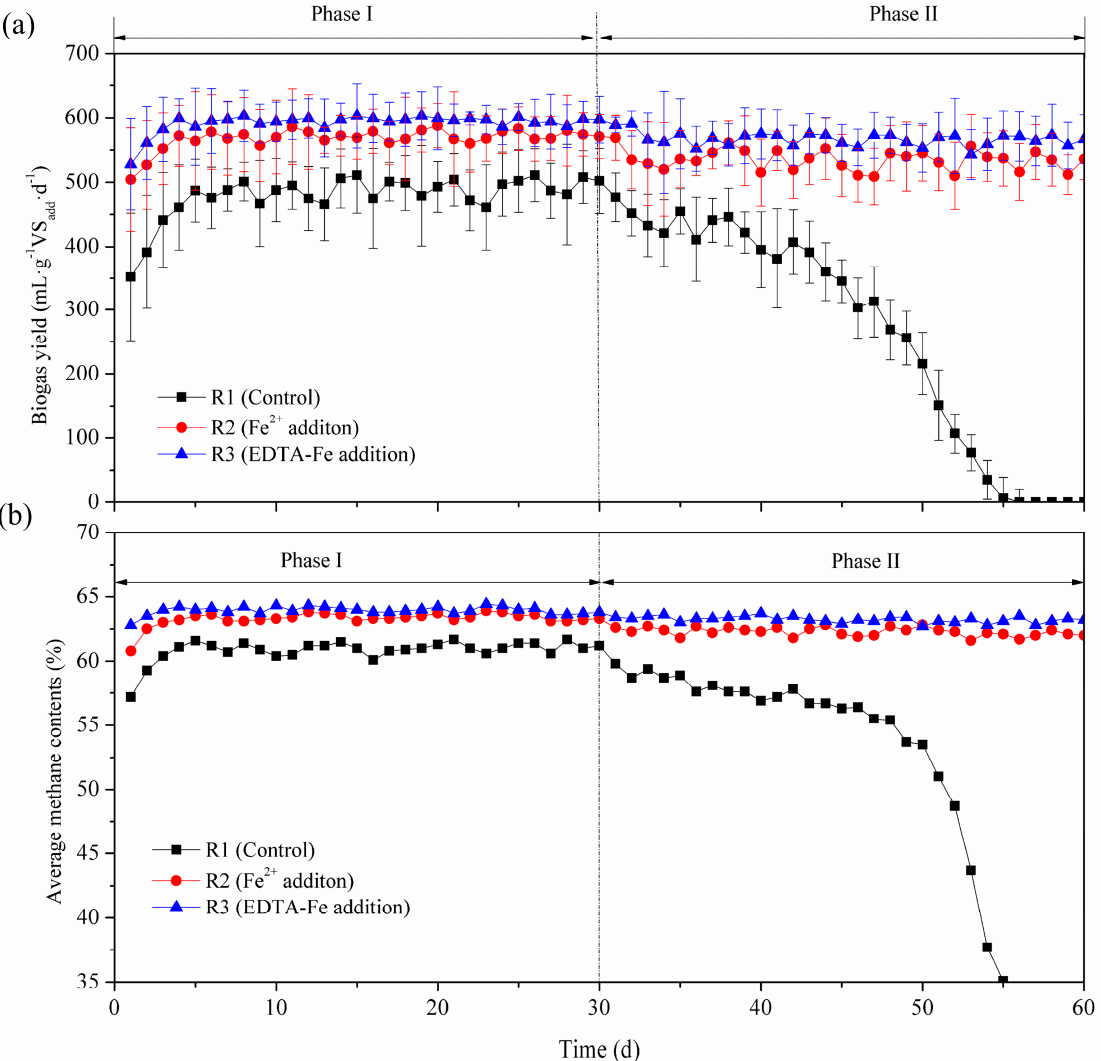
Figure 1. Changes in ( a ) biogas yields and ( b ) methane contents with different additives and operating parameters. Legend: EDTA, ethylenediaminetetraacetic acid.